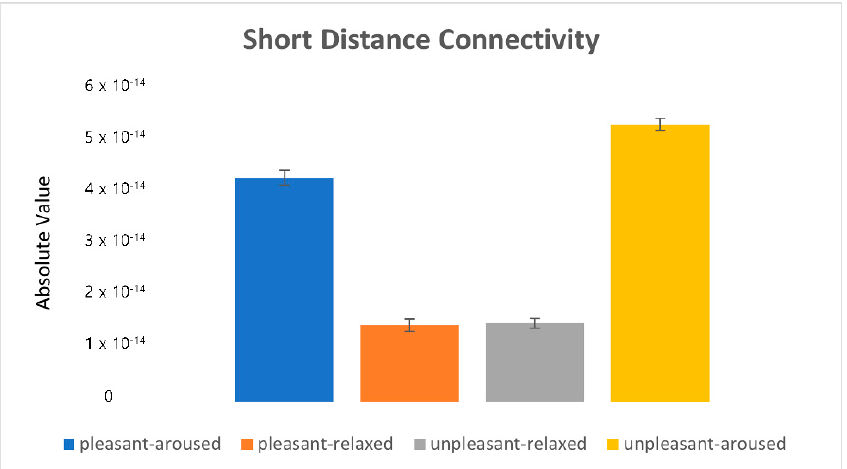
Figure 20. The absolute value in the short-distance connectivity.